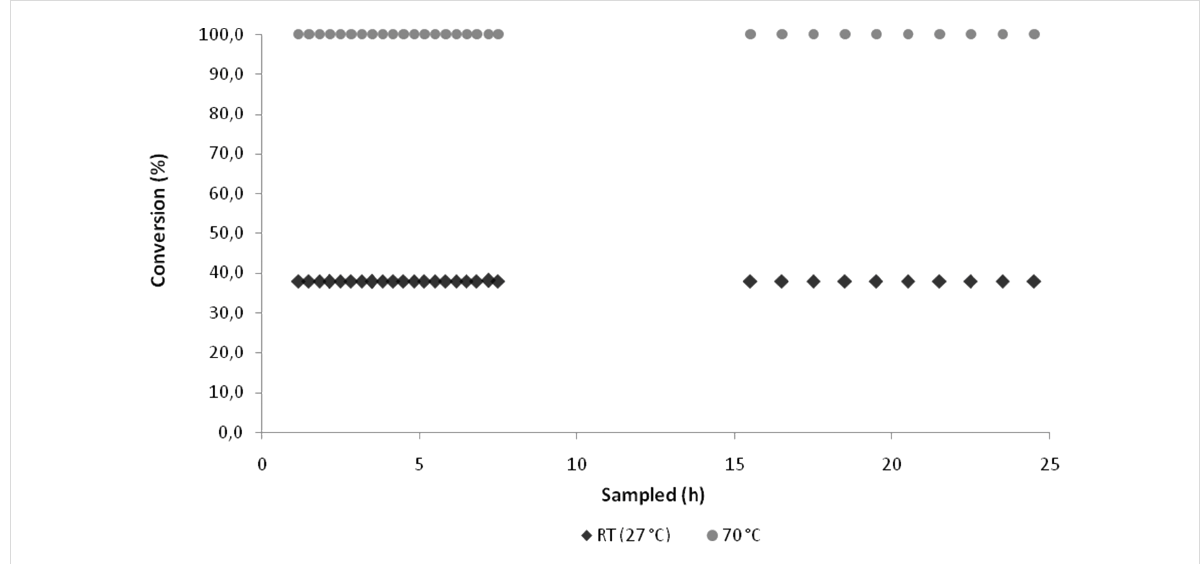
Figure 5: Illustration of the enzyme 4 stability to H 2 O 2 ( 2 ) for the conversion of 1-methylcyclohexene ( 6 ) to 1-methylcyclohexene oxide ( 7 ) (residence time = 2.6 min) at 27 °C and 70 °C over a 24 h period.